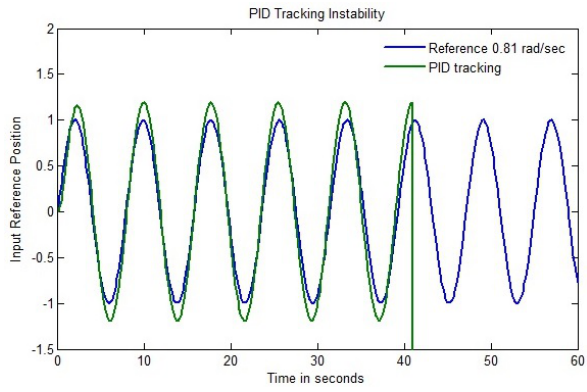
Figure 6: PID controller instability.